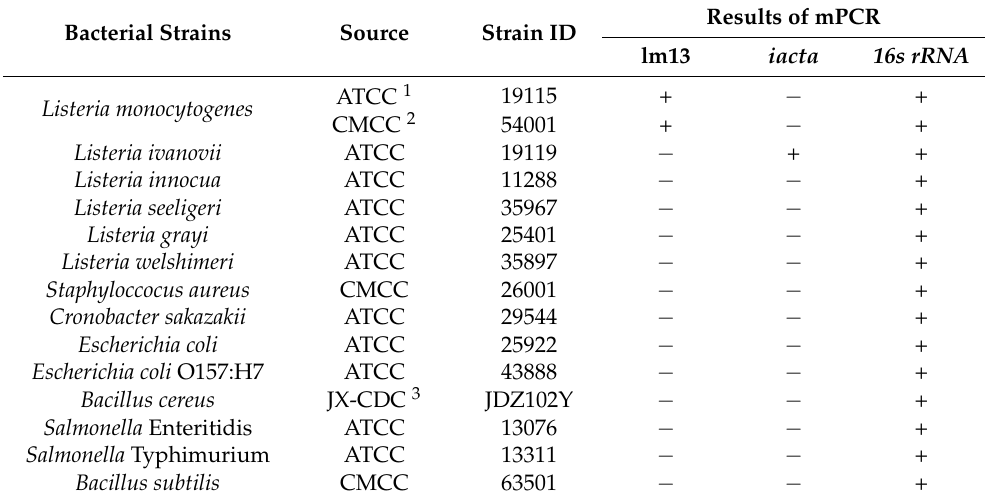
Table 2. Bacterial strains used in this study with results of the mPCR